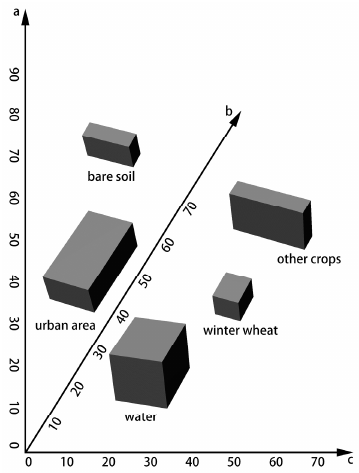
Figure 3. The parallelepiped classifier in the 3D feature space. Each axis ( a , b , c ) represents band values of the remote sensing image. The boxes represent the classes which we defined as the decision boundaries using the training regions of interest (ROIs).